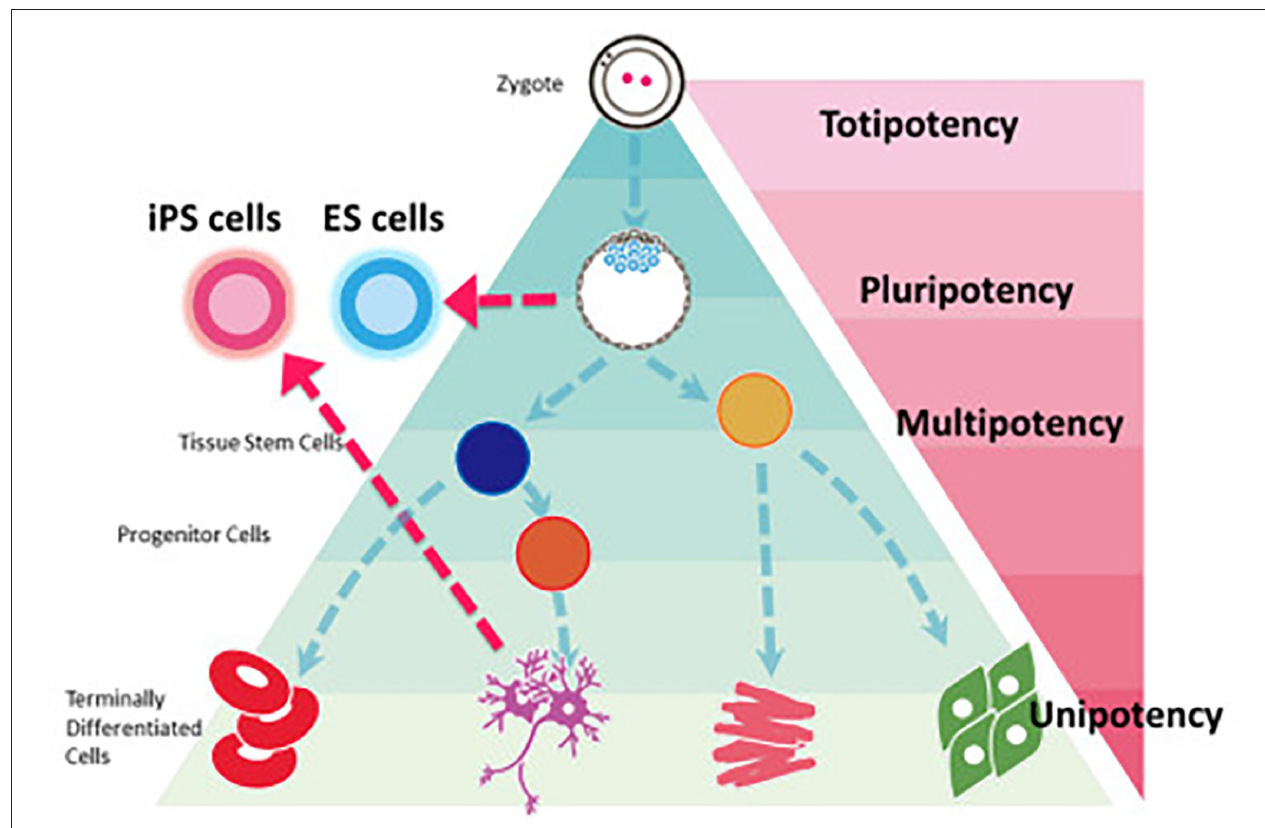
FIGURE 1 | Stem cell classification based on potency. iPS cells can be reprogrammed from a fully differentiated cell to regain the pluripotency seen in embryonic stem cells. Most regenerative engineering applications focus on the use of either iPSCs or multipotent stem cells. Reprinted Sugawara et al.